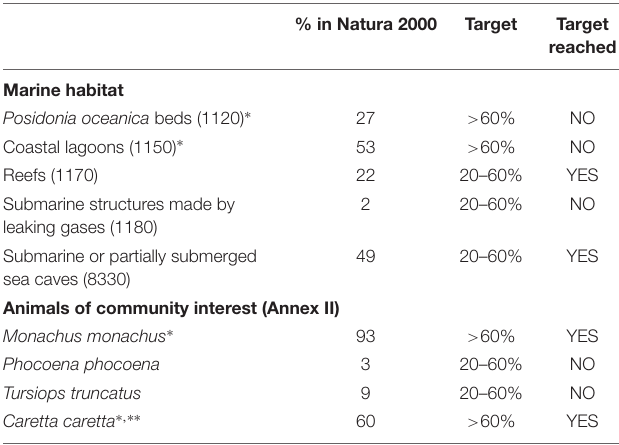
TABLE 1 | Percent coverage of marine habitat types and species of community interest by the Natura 2000 network in the Aegean Sea by the end of